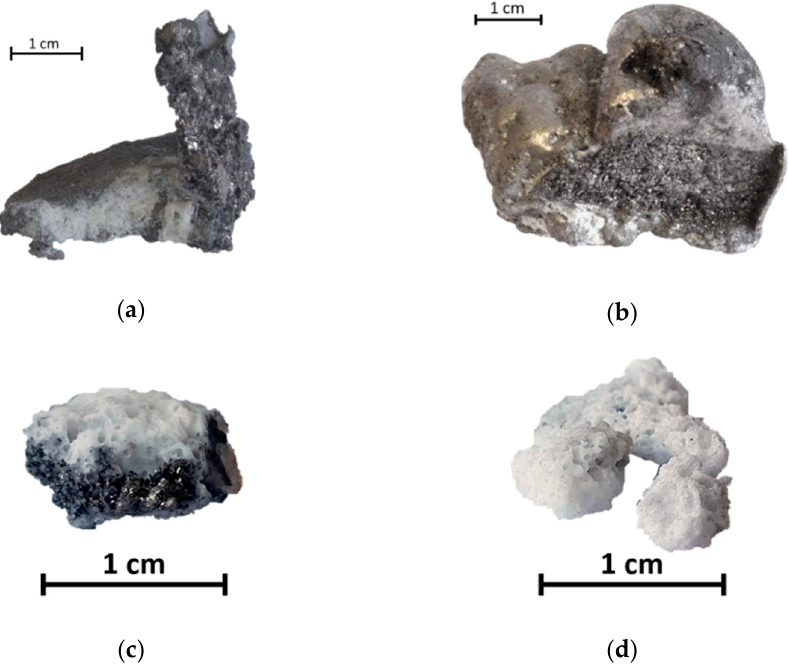
Figure 10. Obtained metal and slag samples from the IM_NCA_C experiment. ( a ) Metal sample 1 which is strongly fused with the produced slag. ( b ) Metal sample 2 with very little slag inclusions. ( c